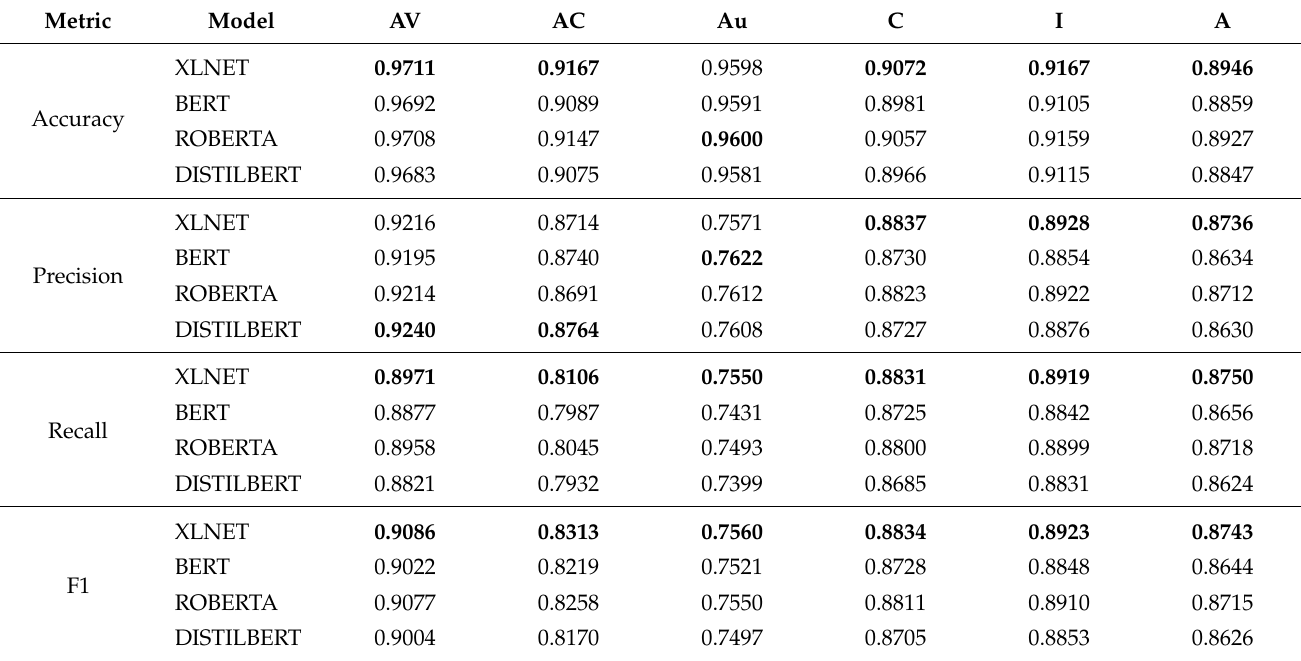
Table 5. Comparison of the effects of the four pre-trained models on the CVSS v2